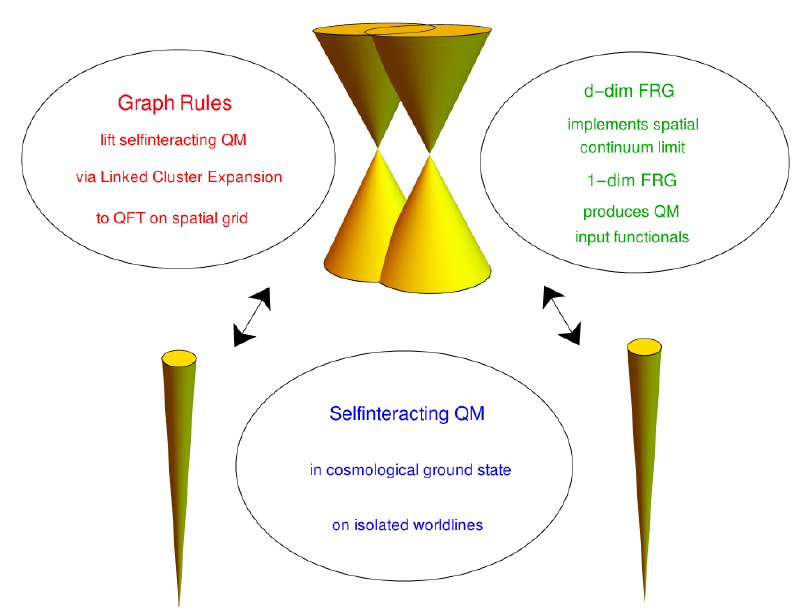
Figure 2. Schematic interplay between the anti-Newtonian expansion, graph rules, and the FRG on Friedmann–Lemaître